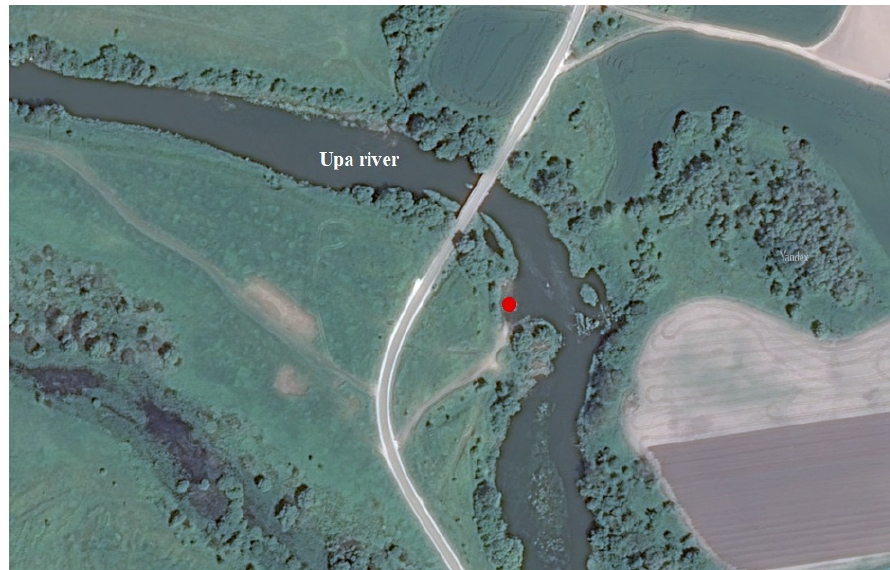
Figure 1. Sampling site (Upa River floodplain, Tula Oblast).